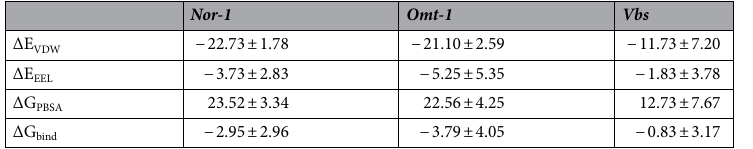
Table 4. The energy components predicted by MM/PBSA analysis (kcal mol −1 ). *Mean ± SD. ΔE EEL change in